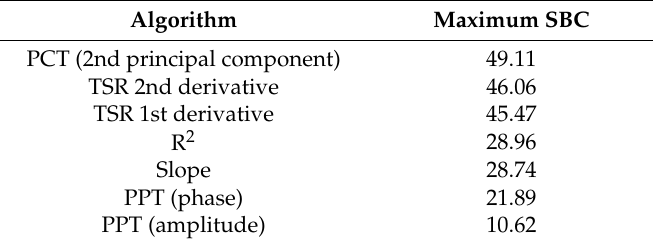
Table 2. The maximum SBC value for each algorithm obtained with Equation